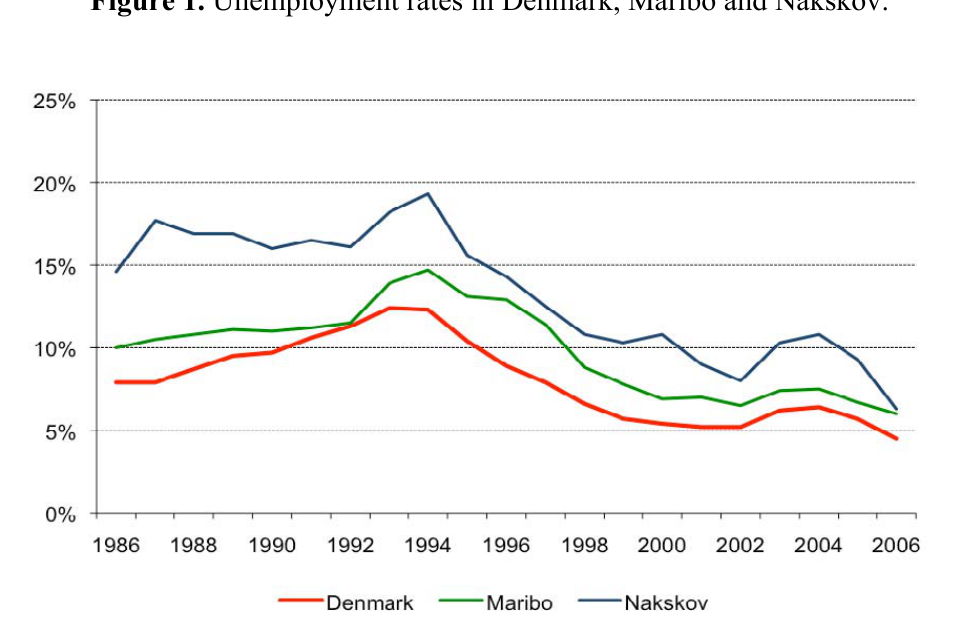
Figure 1. Unemployment rates in Denmark, Maribo and